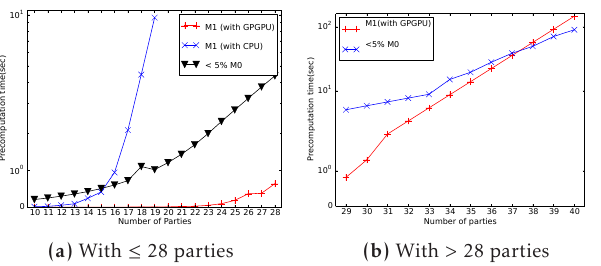
Figure 4. Pre-computation performance with GPGPU